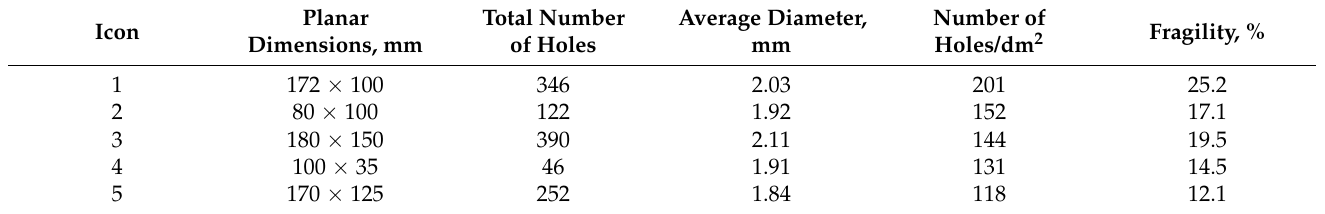
Table 2. Degree of fragility-degradation by the method of excessive porosity given by insect